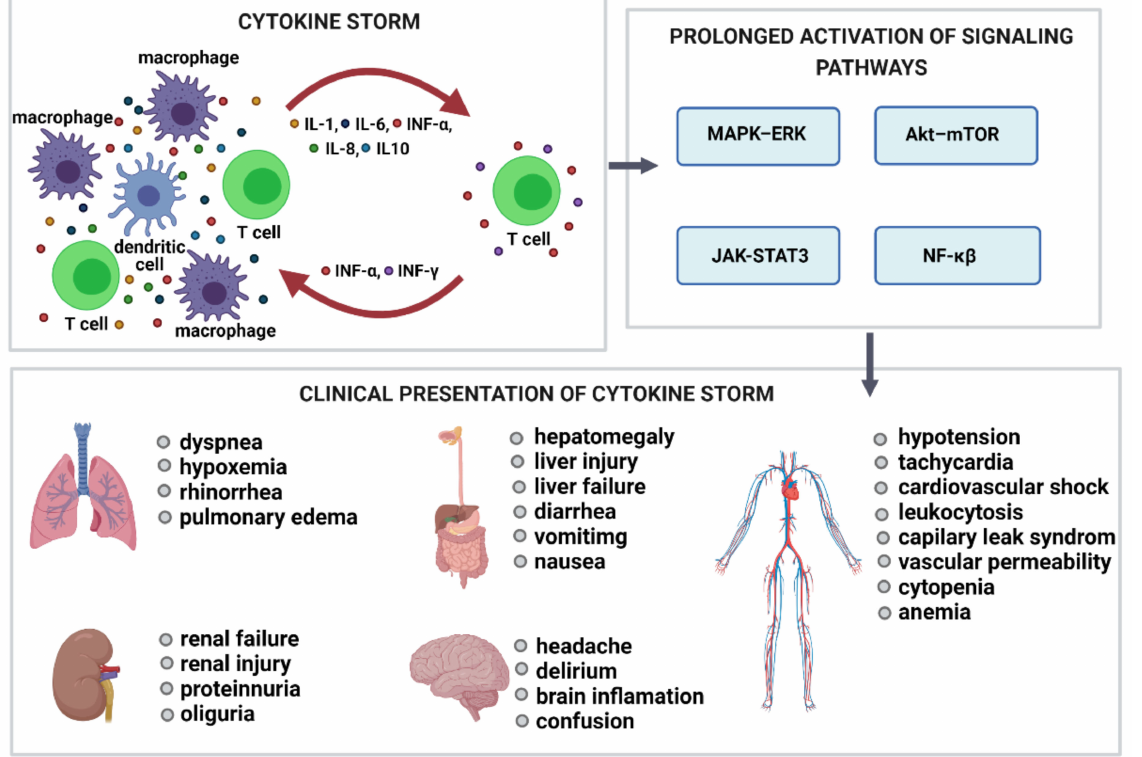
Figure 4. Cytokine storm. Cytokine storm is the result of the rapid release of numerous pro-inflammatory cytokines, including INF- γ , INF- α , IL-1, and IL-6. T cells, macrophages, neutrophils, and NK cells are most often involved in the cytokine storm pathogenesis. The activation of primary T cells or immune cells’ lysis stimulates the production of IFN- γ and TNF- α , which activate other immune cells and endothelial cells to release more pro-inflammatory cytokines. The excessive production of IL-6 constantly activates the JAK–STAT3, Akt–mTOR, and MAPK–ERK signaling pathways. Their prolonged activation stimulates immune cells to produce more cytokines, which causes hyperinflammation and multiple organ failure. JAK–STAT3, Janus kinase-signal transducer and activator of transcription 3; MAPK, mitogen-activated protein kinase; mTOR, mammalian target of rapamycin; NF- κ B, nuclear factor κ